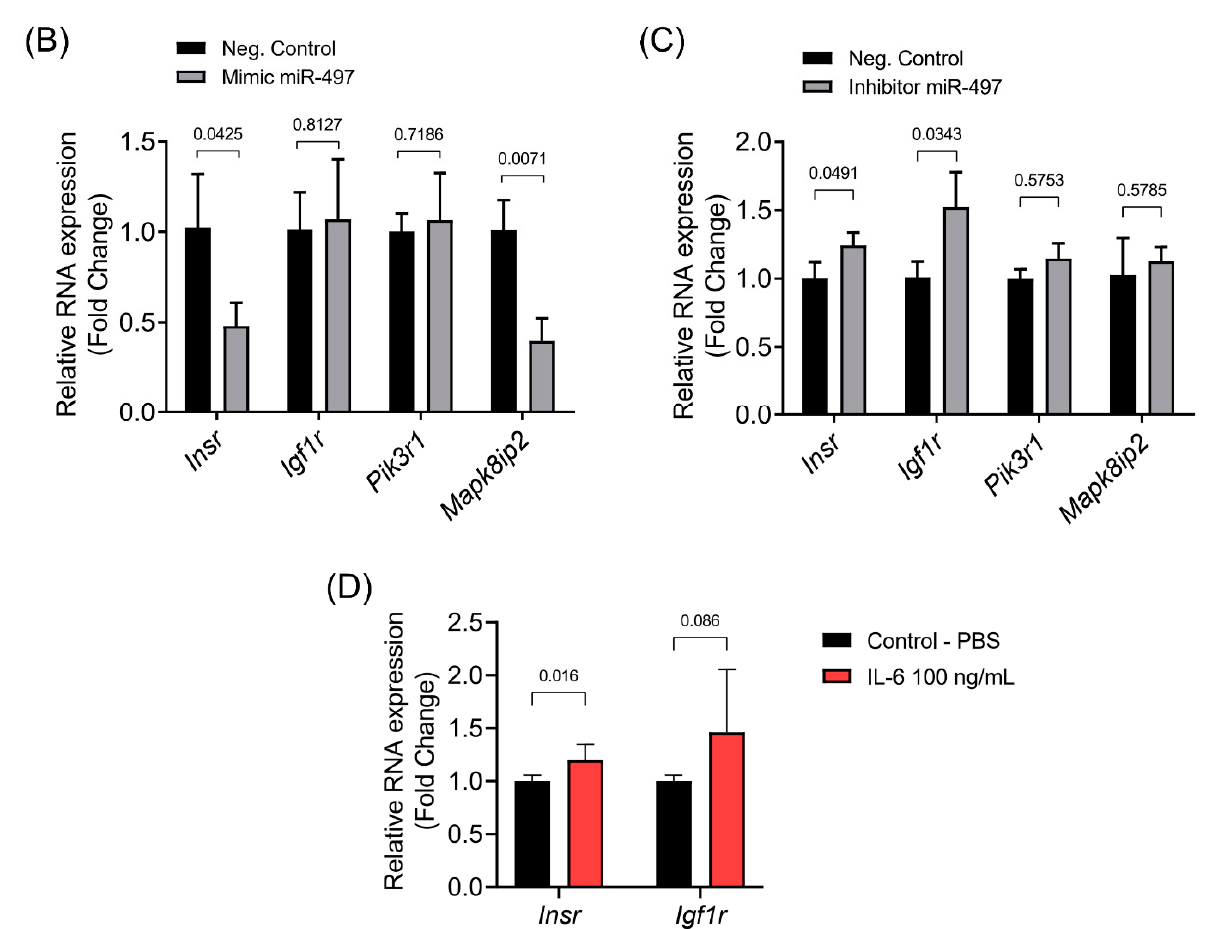
Figure 5. miR-497-5p target genes enrich the insulin-growth factor pathway. ( A ) Biological processes terms (GO) enriched for miR-497-5p target genes ( p -value ≤ 1.82 × 10 − 2 ). Insr , Igf1r , Pik3r1 , and Mapk8ip2 mRNA levels in differentiated C2C12 myotubes transfected with miR-497-5p mimic ( B ) or inhibitor ( C ). ( D ) Insr and Ingf1r expression levels in differentiated C2C12 myotubes treated with IL-6 and control (PBS). RT-qPCR data are represented as fold change (2 − ∆∆ Ct ) relative to Rpl13a . Data represent the average of three independent experiments with standard deviation. Statistical difference was analyzed by Student’s t -test. Insr : insulin receptor; Igf1r : insulin-like growth factor 1 receptor; Pik3r1 : phosphoinositide-3-kinase regulatory subunit 1; Mapk8ip2 : mitogen-activated protein kinase 8 interacting protein 2.